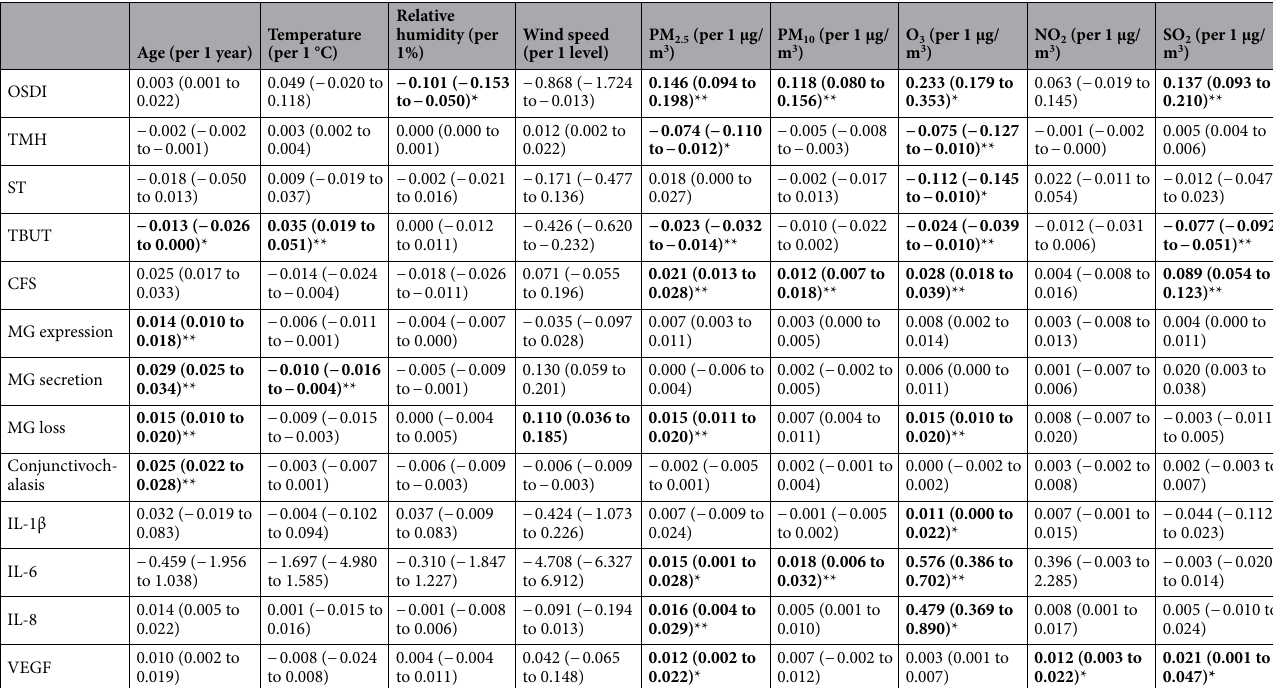
Table 3. Multiple linear regression analysis: effects of air quality on ocular surface and tear cytokines. PM particulate matter, O